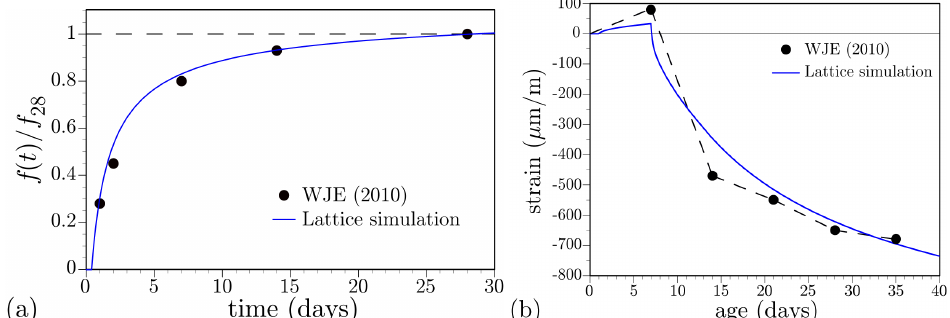
Figure 19. Property development in on-site cast and simulated specimens: ( a ) splitting tensile strength; and ( b ) shrinkage